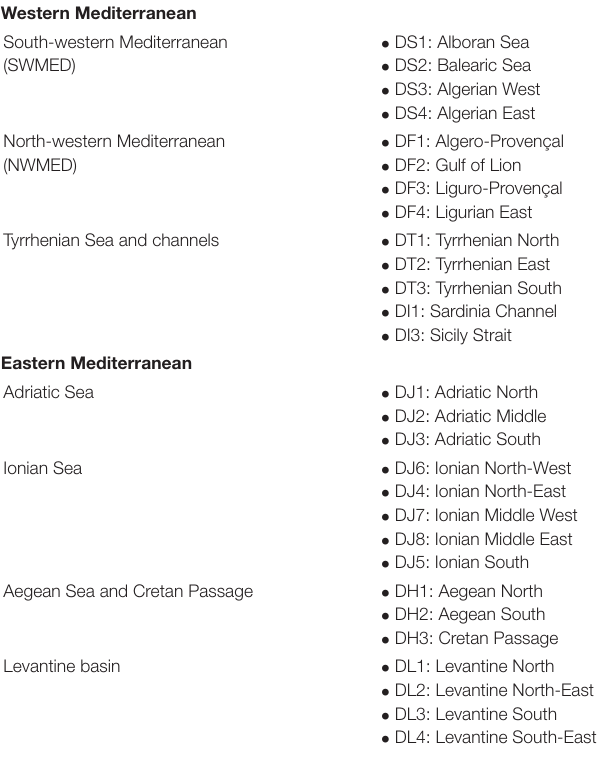
TABLE 1 | Sub-regions in the Mediterranean Sea [as defined by Manca et al. (2004)]. Western Mediterranean South-western Mediterranean